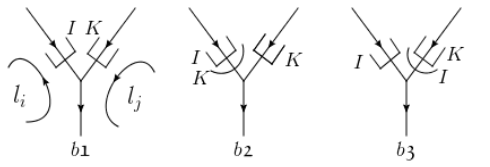
Figure 42. The three possibilities of net approximations, whose associated pinch surfaces are nested with (cid:12)gure 40( b ).